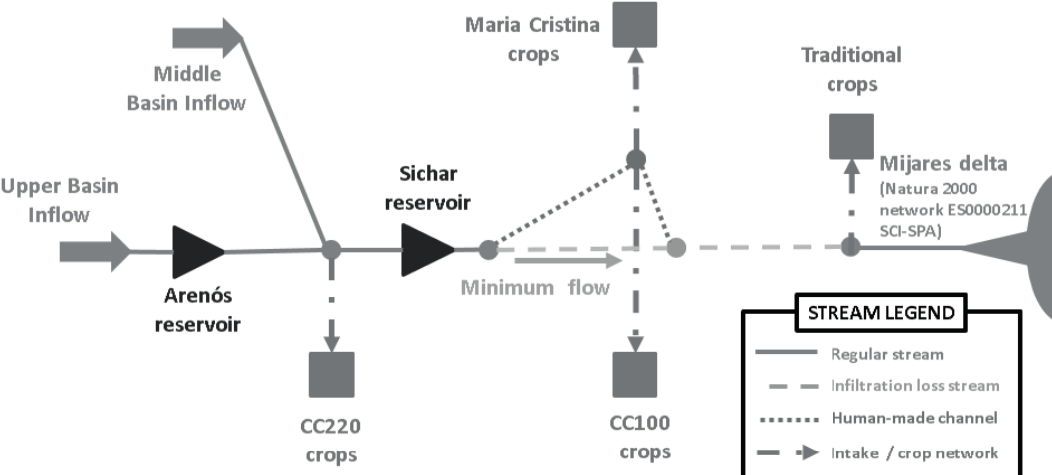
Fig. 1 Mijares River water resources system introduced in